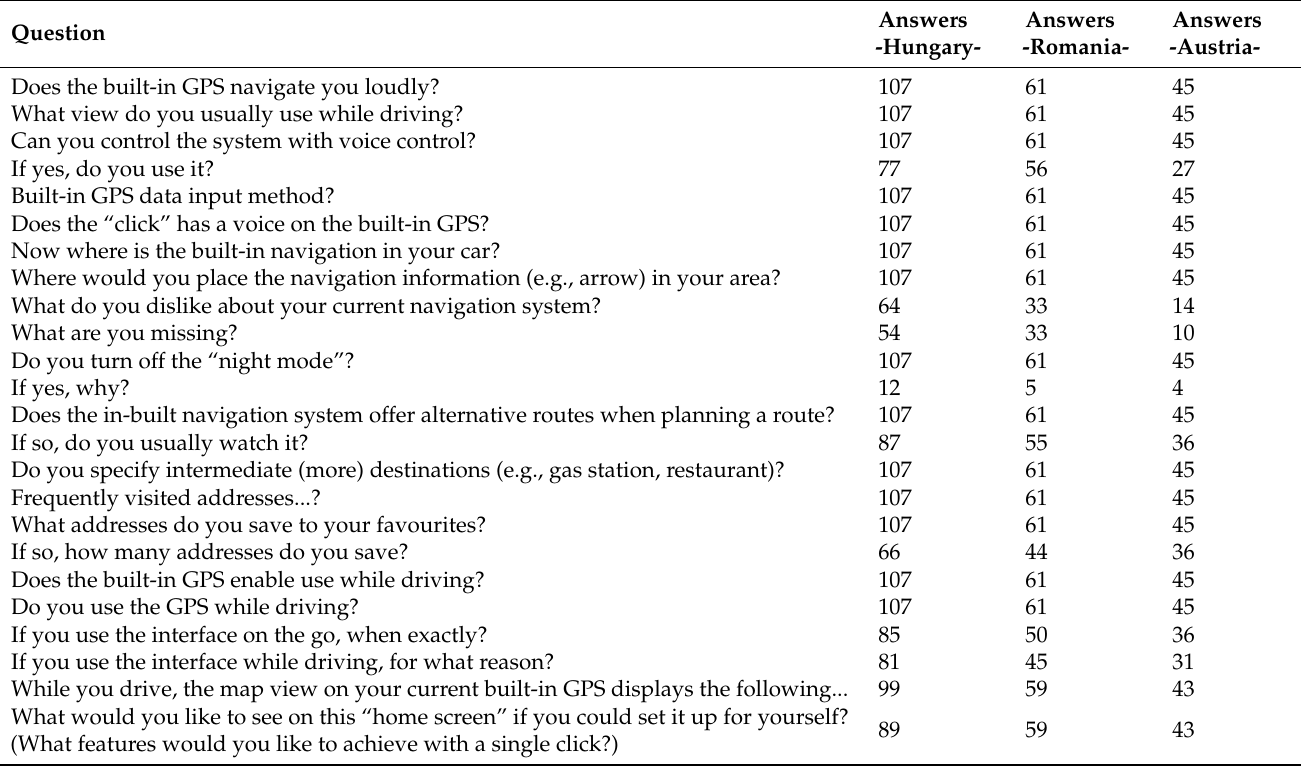
Table 1. The questions elaborated for this paper, and the number of respondents for each country.